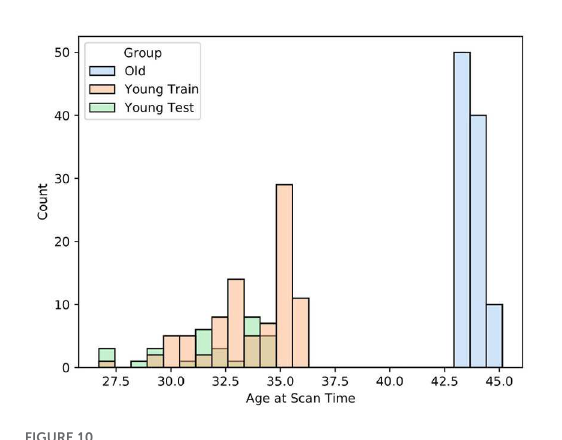
FIGURE10 This figure depicts the age distributions of the source data Old and the target data Young Train . Additionally, the age distribution of the held-out test set for the young population Young Test is shown. We carried out a t -test which determined